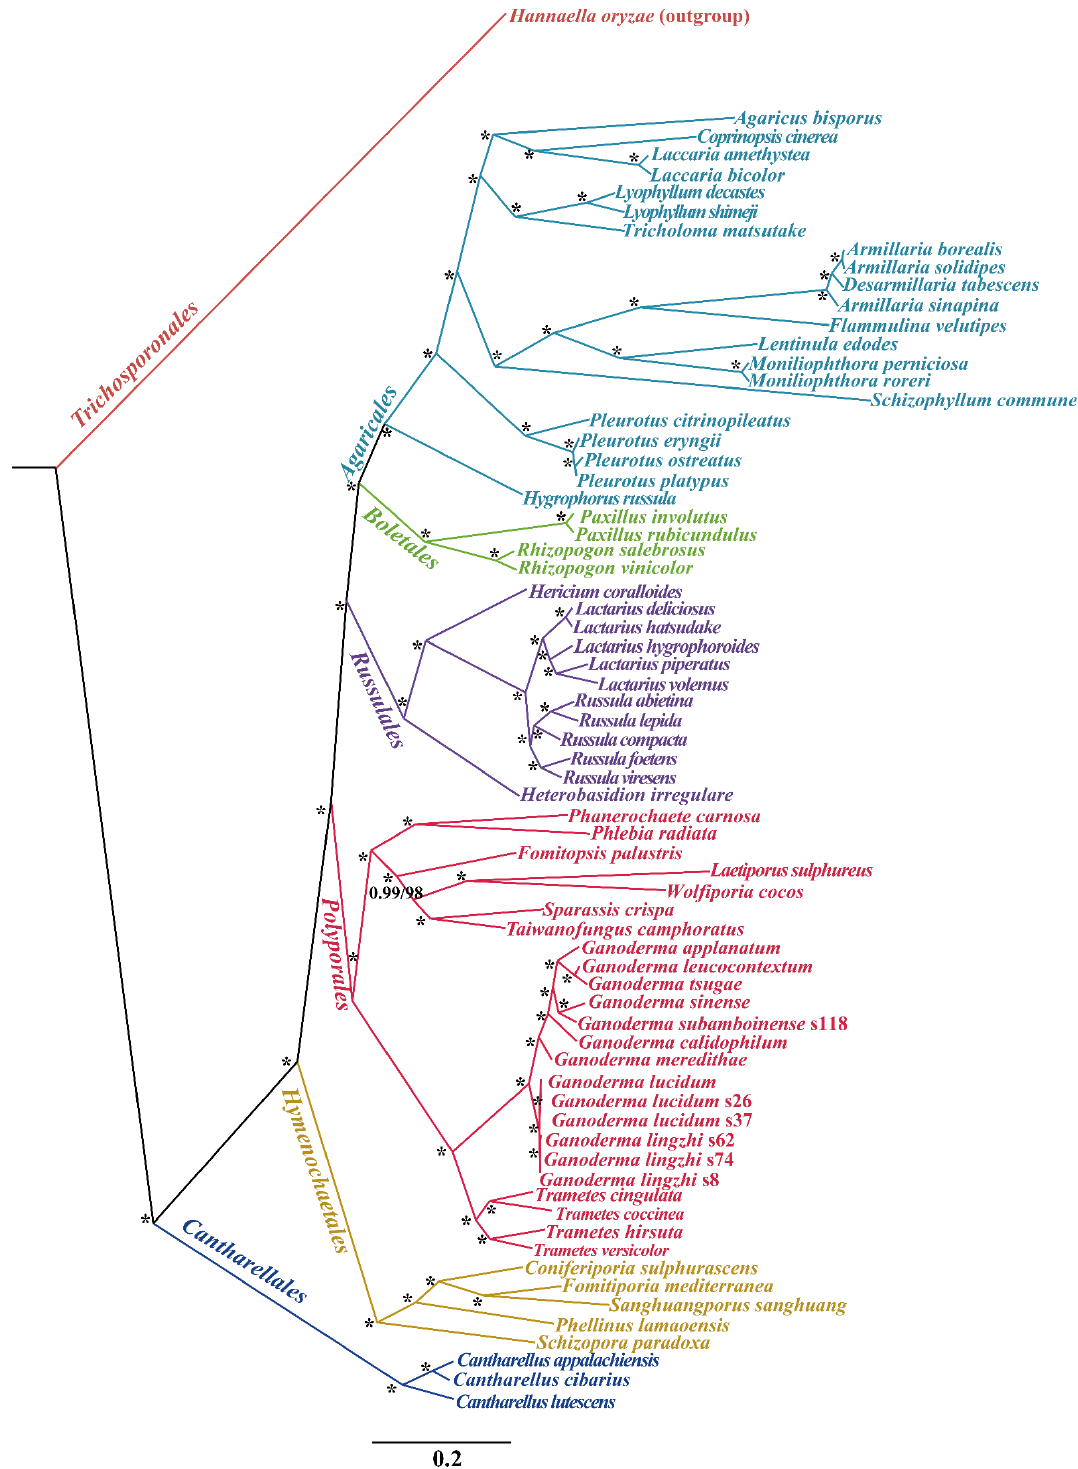
Figure 7. Phylogeny of 71 Agaricomycetes species based on 14 protein-coding genes using the Bayesian inference (BI) and maximum likelihood (ML) methods. The phylogenetic trees were generated by MrBayes v3.2.6 and then exported by FigTree v1.4.3. Support values are Bayesian posterior probabilities (before slash) and bootstrap (BS) values (after slash). The asterisk indicates that the BPP value is 1 and the BS value is 100 of the clades. The species and NCBI accession numbers for the mitogenomes used in the phylogenetic analysis are provided in Supplementary Table